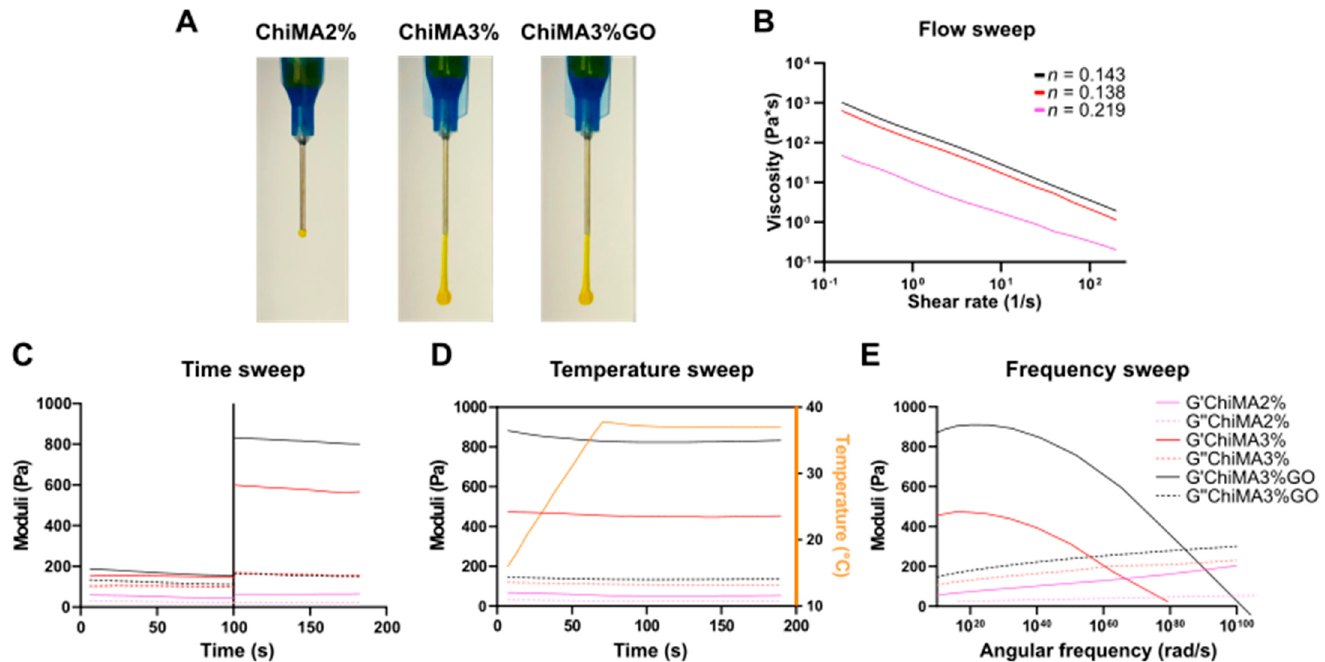
Figure 6. ( A ) Manual injection of the hydrogels through a 21-gauge needle. ( B ) Flow sweep of photocrosslinked samples. ( C ) Time sweeps before and after blue-light photocrosslinking. ( D ) Temperature sweep of photocrosslinked samples between 5 °C and 37 °C. ( E ) Frequency sweep of photocrosslinked samples.